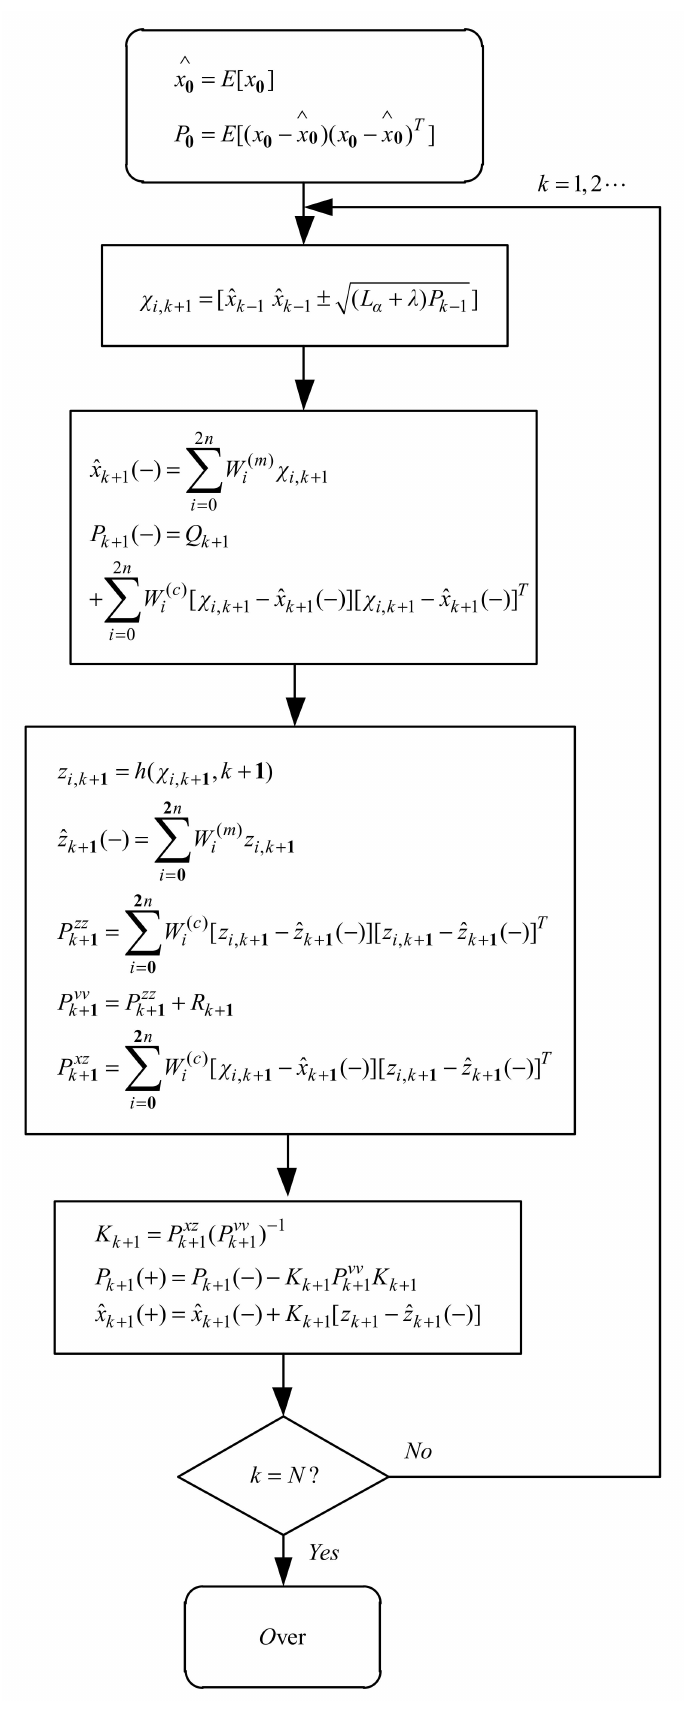
Figure 6. UKF estimation